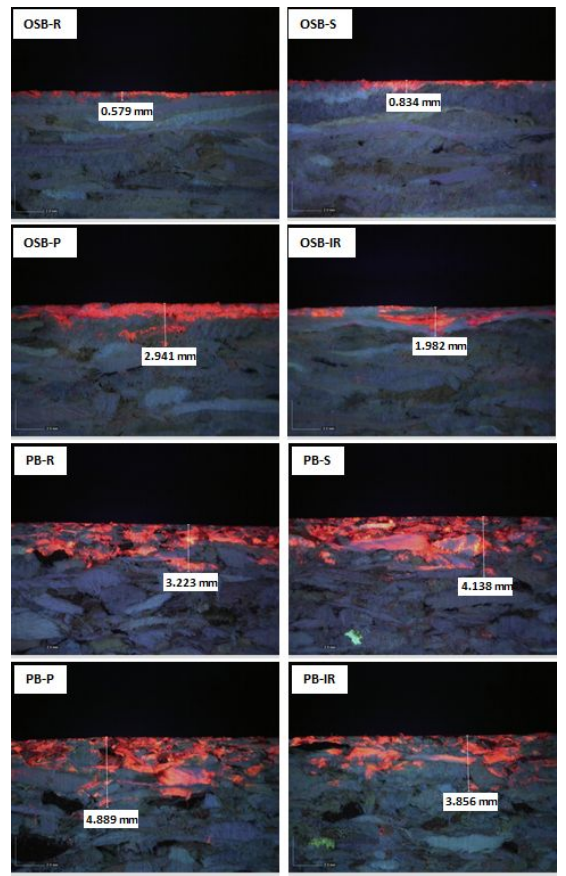
Figure 6. Micrographs of water penetration depth on particleboard and OSB samples at 20× magnification (PB-R: raw particleboard, PB-S: sanded particleboard, PB-P: re-pressed particleboard, PB-IR: heated particleboard, OSB-R: raw OSB, OSB-S: sanded OSB, OSB-P: re-pressed OSB, and OSB-IR: heated OSB).